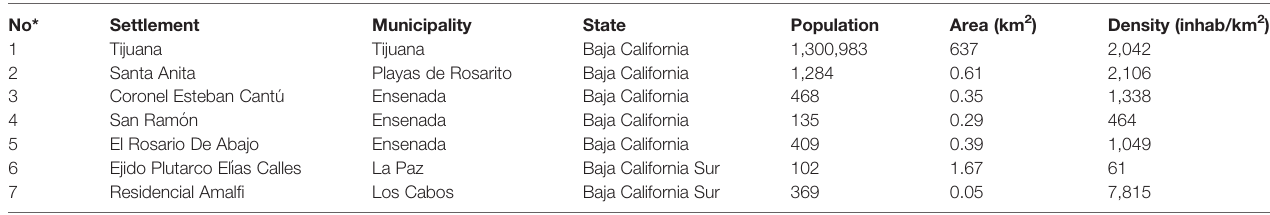
TABLE 1 | Main demographic characteristics of coastal